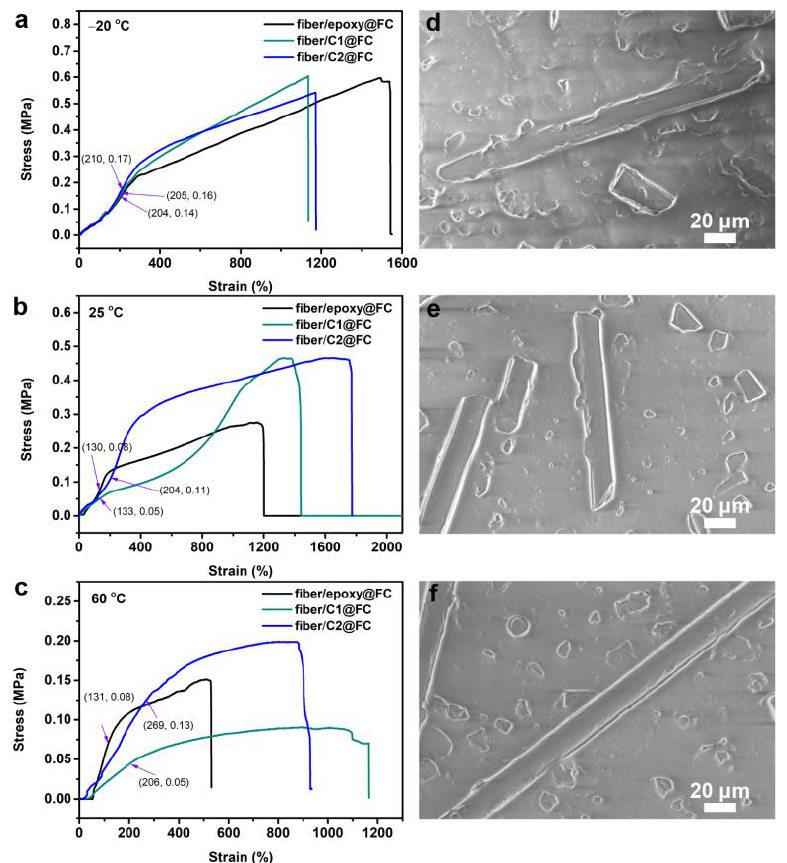
Figure 5. Stress – strain curves of fiber/epoxy@FC, fiber/C1@FC, and fiber/C2@FC at different tem- Figure 5. Stress–strain curves of fiber/epoxy@FC, fiber/C1@FC, and fiber/C2@FC at different peratures: − 20 °C ( a ), 25 °C ( b ), and 60 °C ( c ); SEM images of fiber/epoxy@FC ( d ), fiber/C1@FC ( e ), temperatures: − 20 ◦ C ( a ), 25 ◦ C ( b ), and 60 ◦ C ( c ); SEM images of fiber/epoxy@FC ( d ), fiber/C1@FC ( e ), and fiber/C2@FC ( f and fiber/C2@FC ( f ).